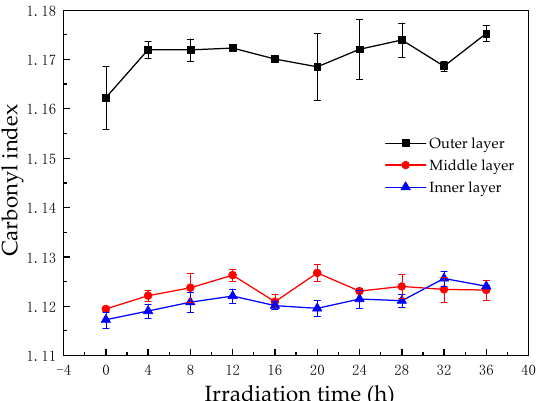
Figure 5. Changes in the carbonyl index of the outer, middle, and inner layers of disposable masks with UV irradiation time. (1) Black line is the carbonyl index of the outer layer. (2) Red line is the carbonyl index of the middle layer. (3) Blue line is the carbonyl index of the inner layer. (For each condition, N = 6).